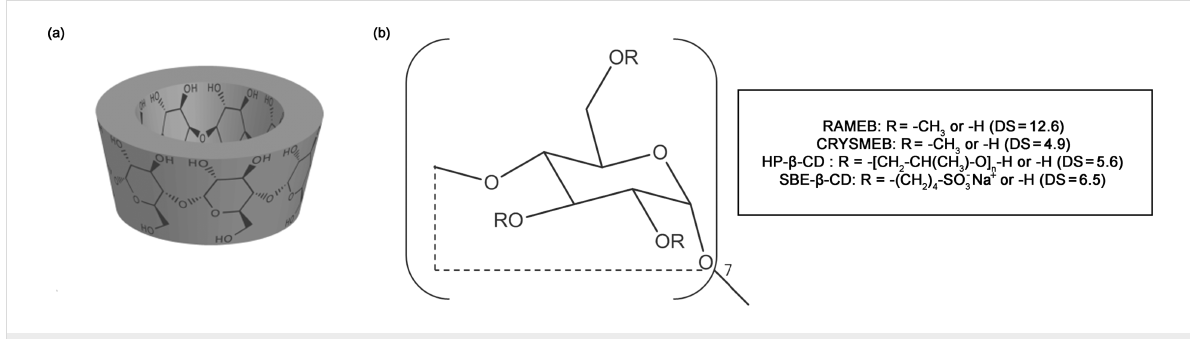
Figure 1: Chemical structure of β -CD (a) and β -CD derivatives